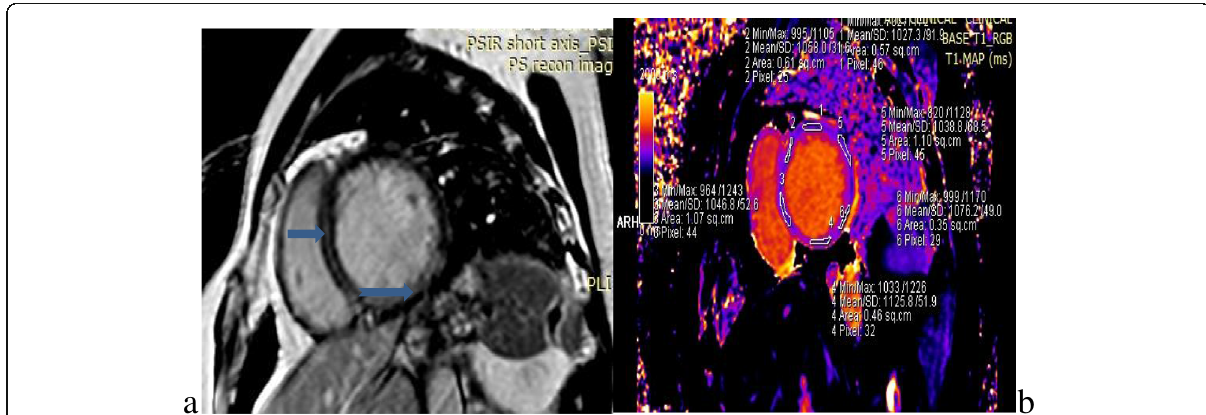
Fig. 5 16 year old male with dilated cardiomyopathy post myocarditis presented with sudden precordial pain like acute myocardial infarction pain, ECG showed ST segment elevation in inferolateral wall (serum creatinine kinease and T-troponin were elevated) ( a ) Late gadolinium enhancement (LGE) was found mid wall septal, inferior and inferolateral segments (arrow). ( b ) Non-contrast-enhanced T1 mapping shows that the native T1 value of the inferolateral segment including LGE is 1125 ms, which is more than 1070 ms